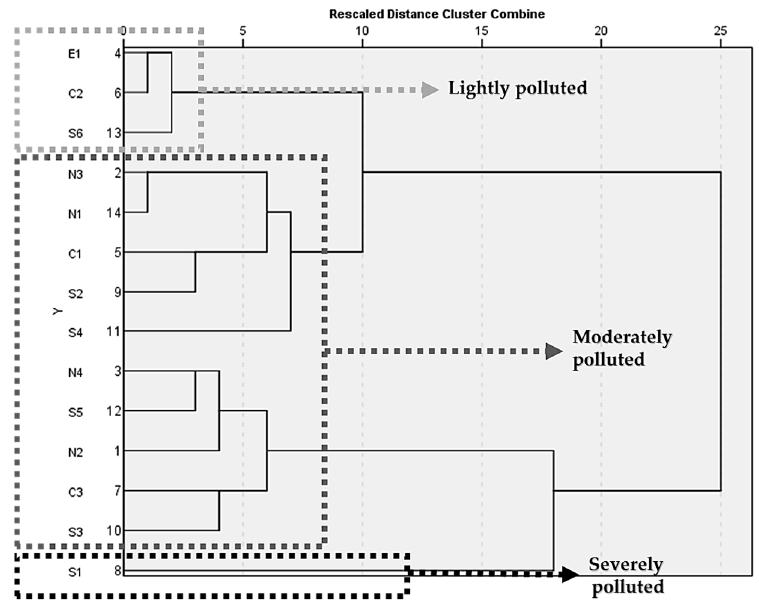
Figure 5. Dendrogram of RPI rank for 14 representative rivers in Taiwan (see Table 1 for the river names associated with the river codes).